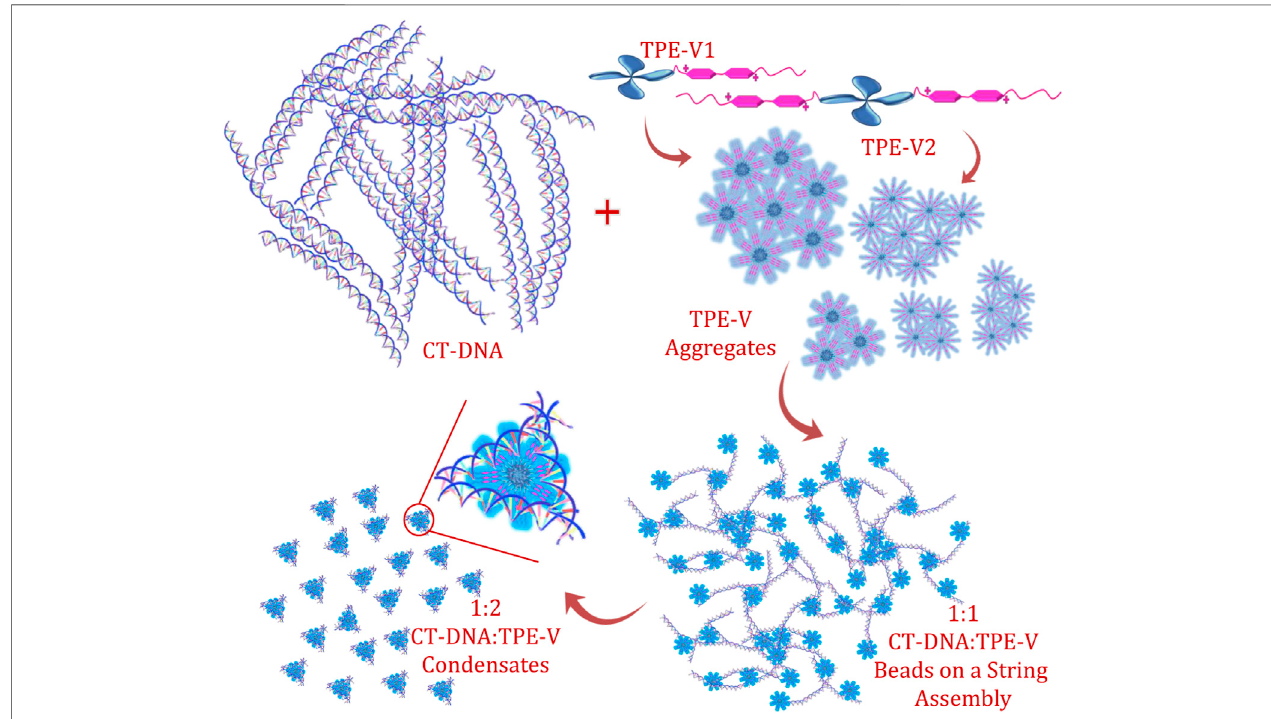
Frontiers in Chemistry |